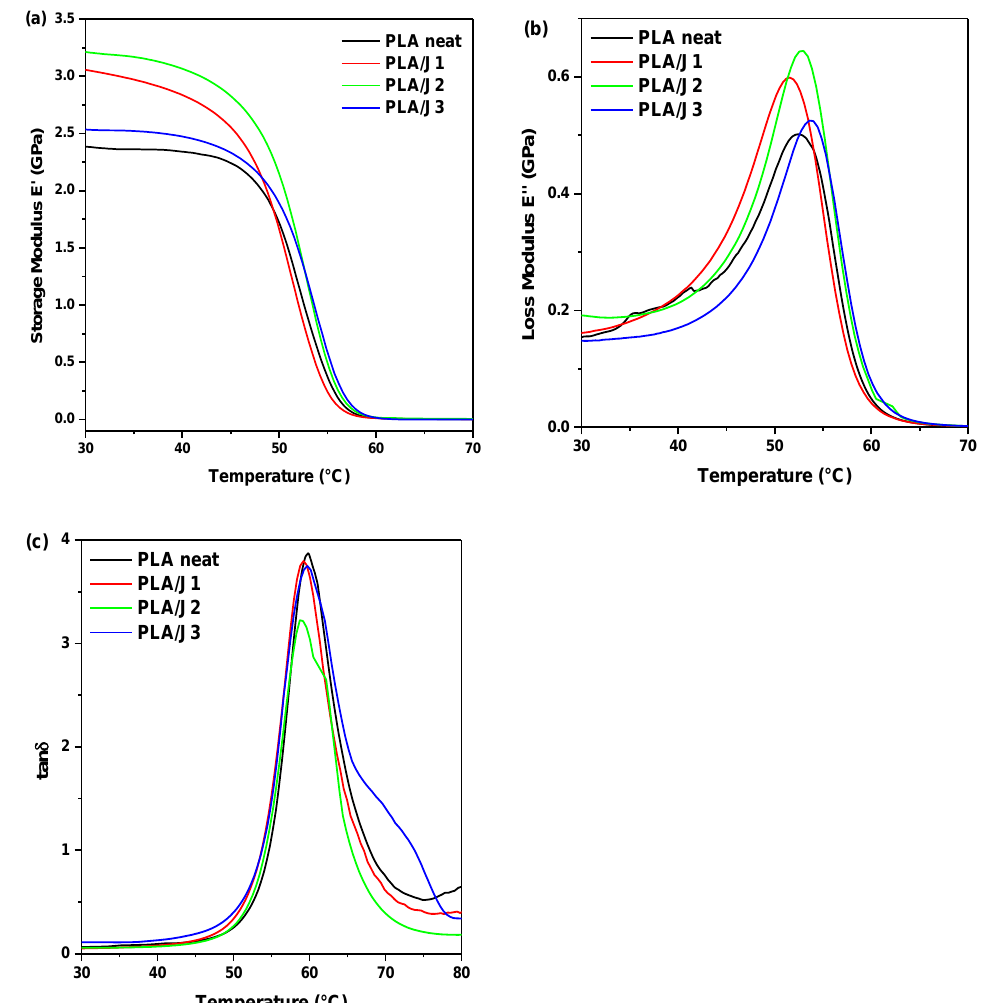
Figure 10. DMA results of the 3D-printed specimens of neat PLA and PLA/J: ( a ) storage modulus E’, ( b ) loss modulus E’’, and ( c ) loss factor tanδ as a function of temperature.